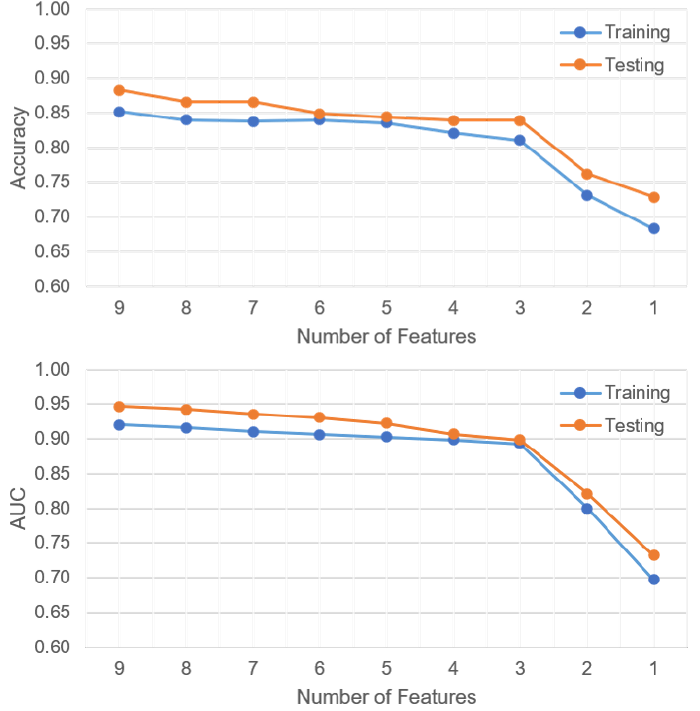
Figure 6. Accuracy and AUC plots of optimized XGBoost model with decreasing number of